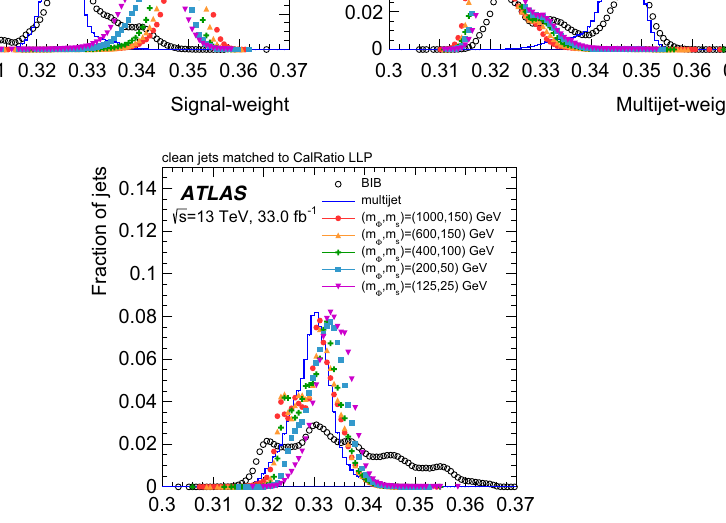
Fig. 4 The distributions of the per-jet BDT weights for a multijet sample, a BIB sample and five signal samples. For the signal samples, the weights for clean jets matched to an LLP decaying in the calorimeter are shown. The multijet and BIB distributions include weights for all clean jets in the